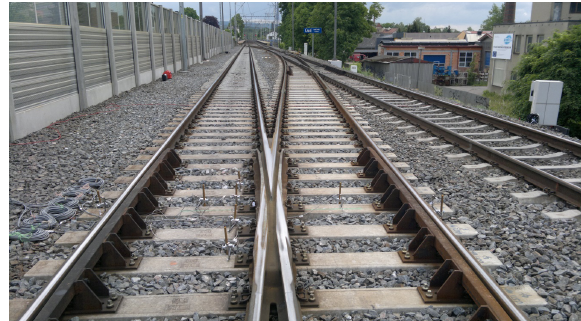
Figure 3. Turnout no. 4 and single crossover with turnout no.